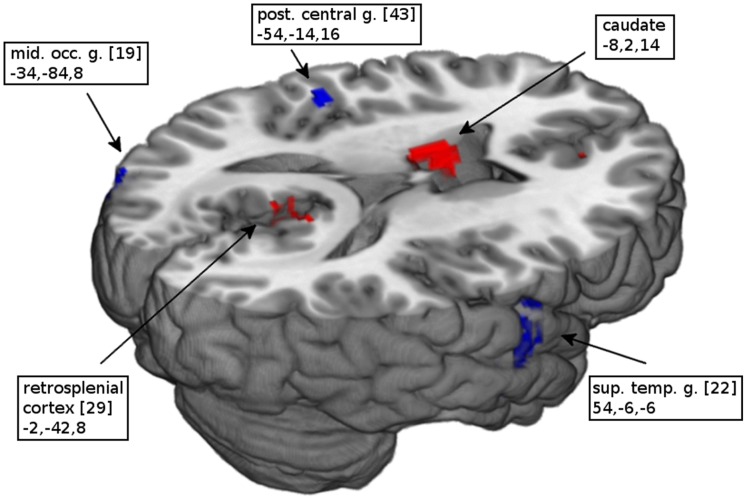
Activation map of controls contrasted with patients.Significantly increased (red) and decreased (blue) activations in PTSD patients compared to trauma-exposed controls in response to trauma-related stimuli. (Numbers in brackets indicate Brodmann areas and coordinates of the peak voxel are in Talairach space).